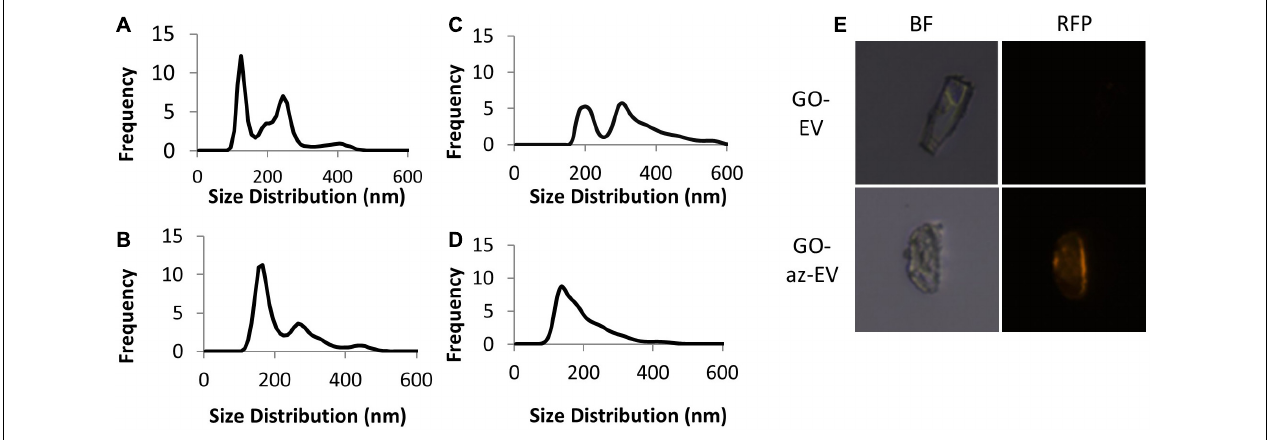
FIGURE 1 | Characterization of nanoparticles. The size distribution of (A) unmodified MSC-EV, (B) azide tagged MSC-EV (az-EV), (C) graphene oxide (GO) and (D) sonicated GO (sGO). (E) Bright field and fluorescence microscopy images of DiI stained plain (EV) and azide tagged (az-EV) MSC-derived EV covalently bound to graphene oxide (GO) were captured with a 40x magnification.